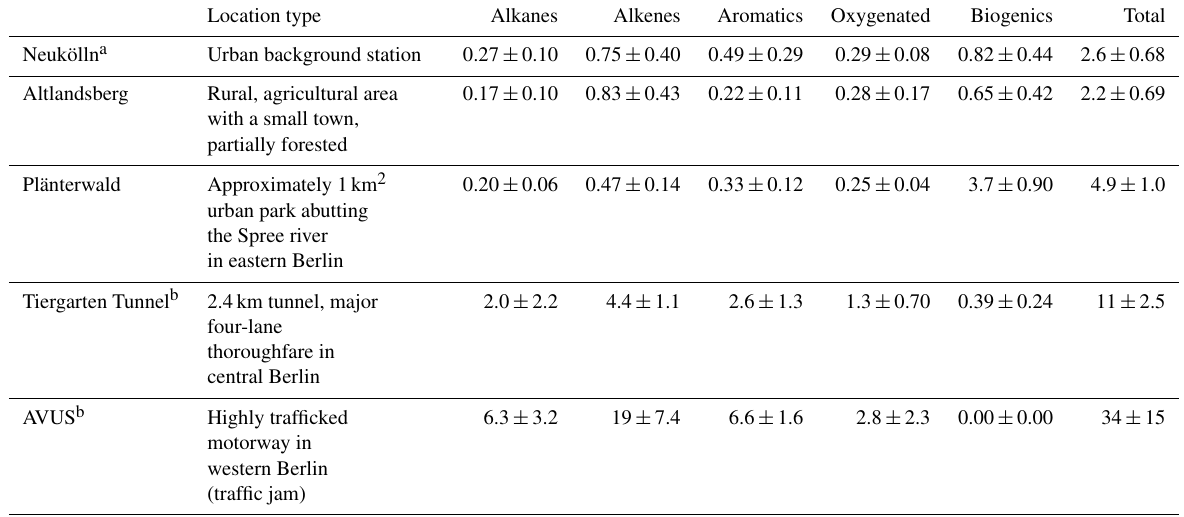
Table 2. NMVOC canister sampling locations, site type, and average OH reactivity (s − 1 ) . Location